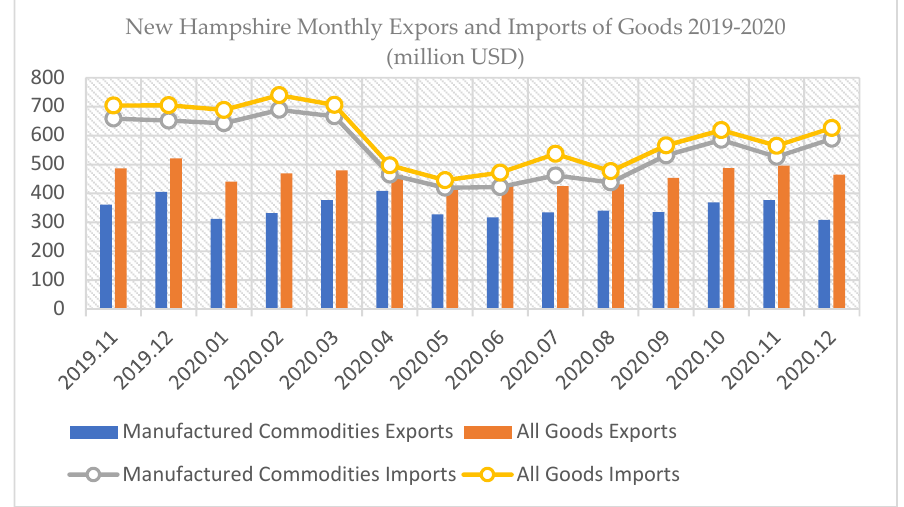
Figure 8. New Hampshire Monthly Expors and Imports of Goods 2019–2020 (million USD) Data source: U.S. Bureau of Economic Analysis, U.S. International Trade in Goods and Services, various months.